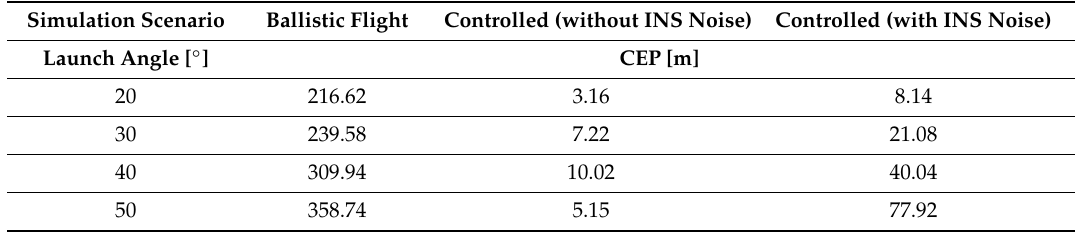
Table 2. Projectile CEP for various simulation scenarios.